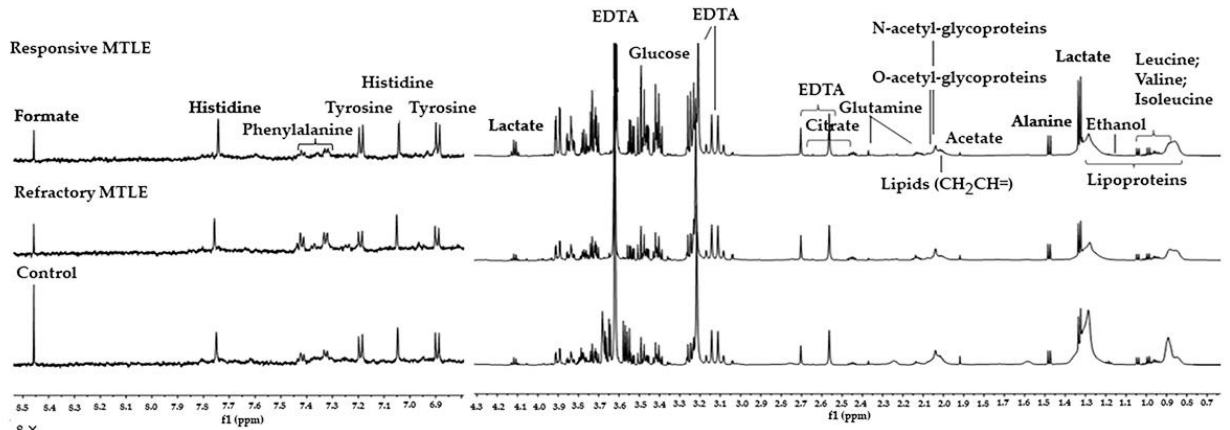
Figure 1. The representative 1 H-NMR spectra of plasma samples of control, responsive, and refractory MTLE subjects. Spectral regions from 0.5 to 9.0 ppm, acquired using CPMG (cpmgpr1d) pulse sequence, are shown. The 7.0 to 8.5 ppm regions were zoomed in (8 × ) for better visualization. The regions of D 2 O and EDTA were removed (//). The following metabolites were identified: lipoproteins; leucine, valine; isoleucine; lactate; alanine; acetate; N -acetyl-glycoproteins; O -acetyl-glycoproteins; glutamine; glucose; tyrosine; histidine; phenylalanine; formate.